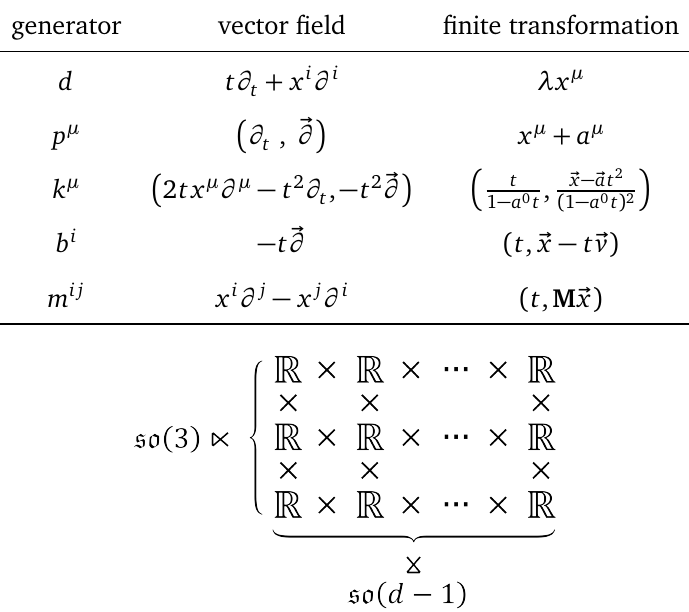
Table 2: GCA symmetry generators as the vector fields on the space-time.